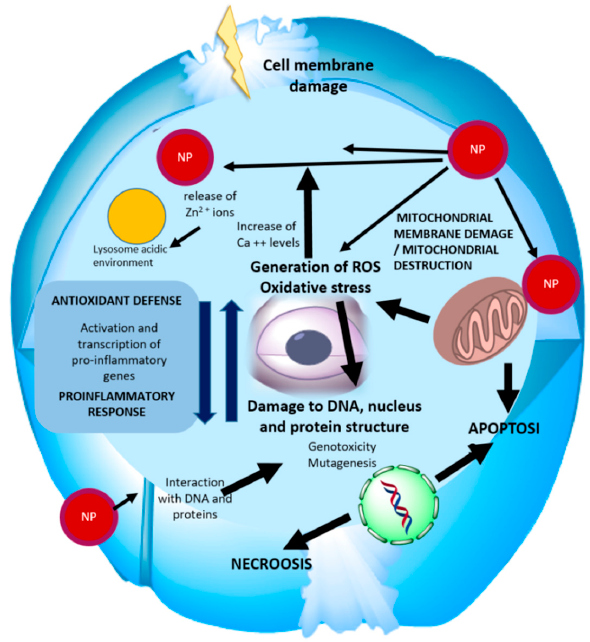
Figure 3 . ZnO nanoparticle toxicity pathways mapped against a stylized cell. Figure 3. ZnO nanoparticle toxicity pathways mapped against a stylized